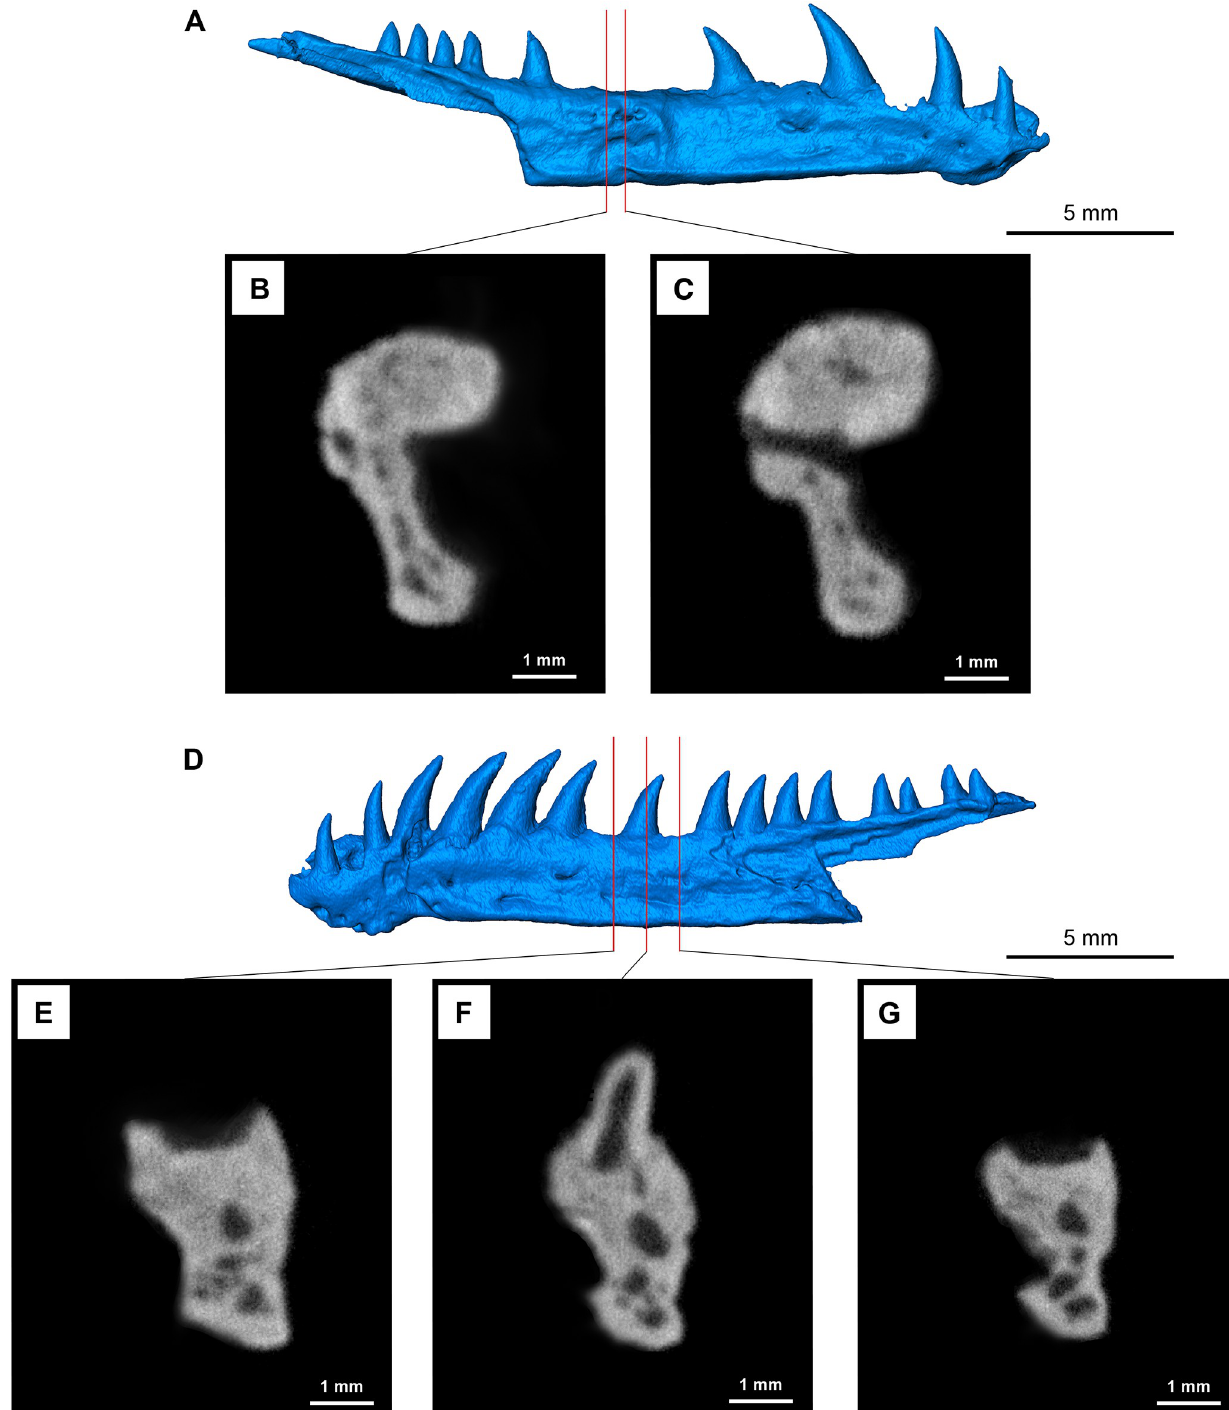
Fig 7. Pathology of right dentary compared to the normal area in the left dentary for (ROMVP 87366). (A) right and (D) left dentary renderings. Individual cross-sectional CT images for (B) and (C) displaying the pathology area, whereas (E), (F), and (G) display the same area but for the normal